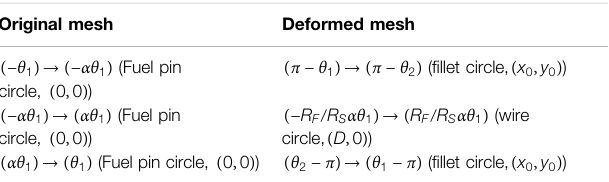
TABLE 1 | Corresponding relationship between the original mesh and the deformed mesh. Original mesh